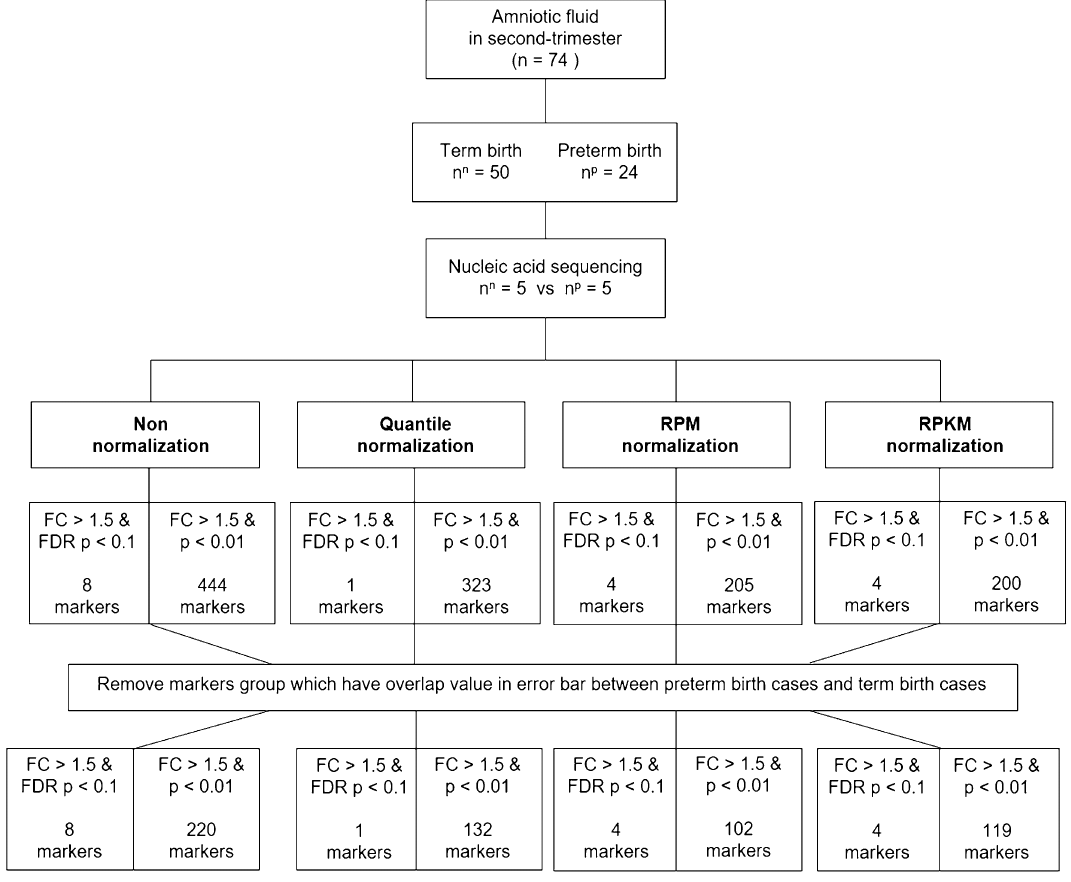
Figure 1. Flow chart of normalization procedures and differentially expressed genes in each normalization method. FDR false discovery rate, FC fold change. The uppercase letter P is used for preterm birth and N for normal term birth.